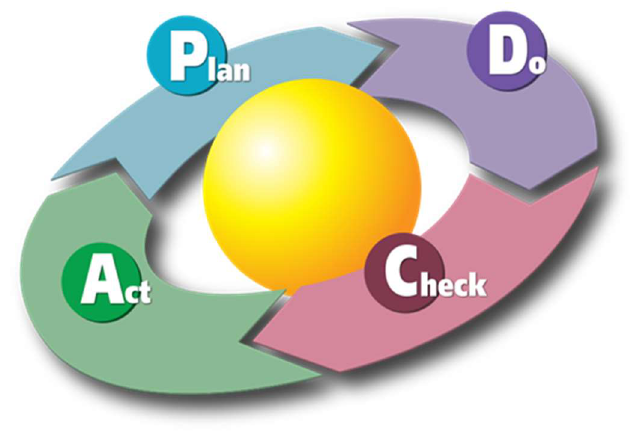
Figure 3: Model PDCA